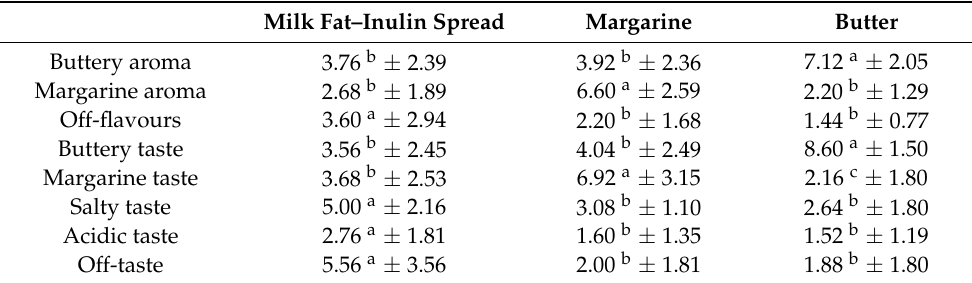
Table 2. Sensory evaluation of the milk fat–inulin spread, margarine and butter. Milk Fat–Inulin Spread Margarine Buttery